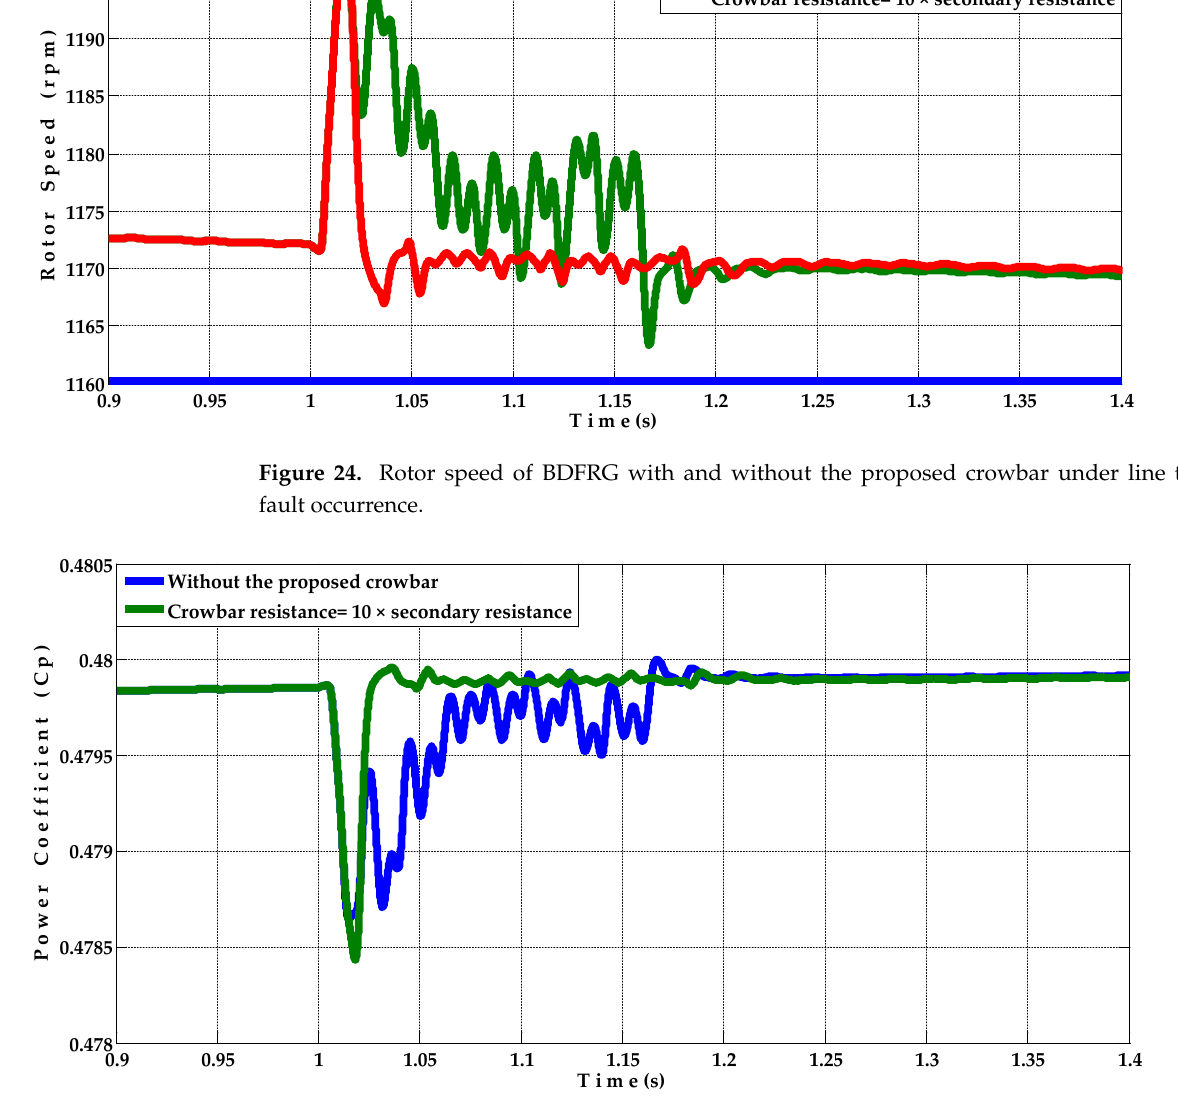
Figure 25. Power coefficient of wind turbine with and without the proposed crowbar under line to line fault occurrence.